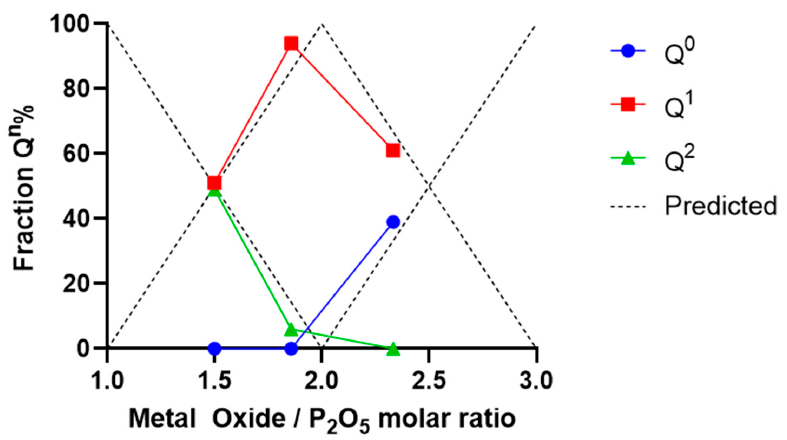
Figure 4. Alignment of P40, P35 and P30 to the predictions presented by Wazer and Fluck (1959) [57].